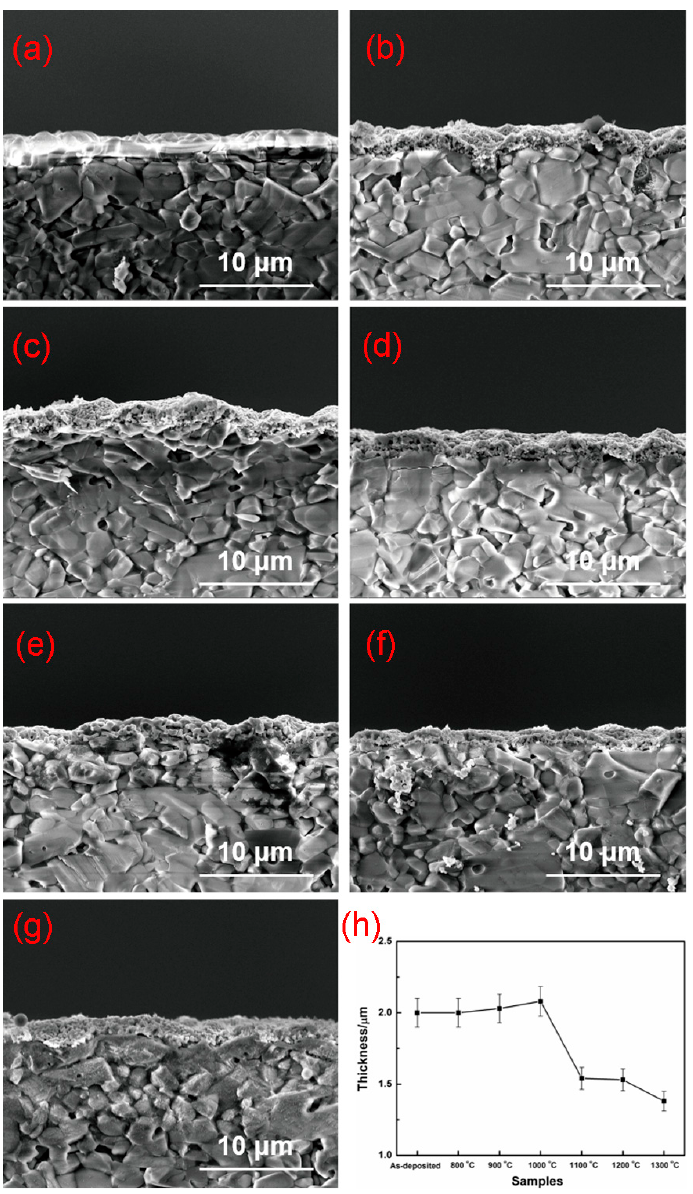
Figure 3. Cross-sections of 0.2LSCO thin films annealed at different temperatures: ( a )